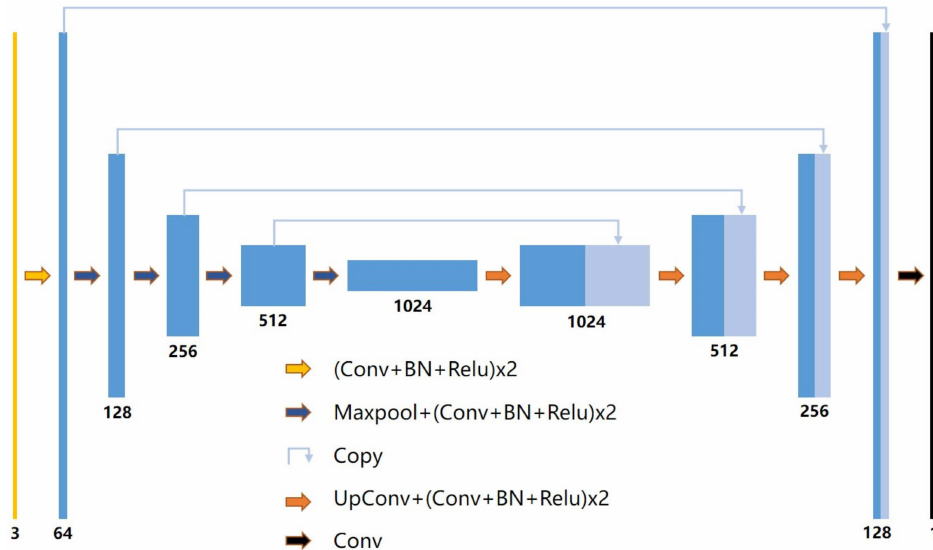
Figure 4. Improved UNet architecture. Conv is a convolutional layer (convolution kernel is 3 × 3 and padding is 1), BN is batch normalization, Relu is the activation layer, Maxpool is the maximum pooling layer, UpConv is the transposed